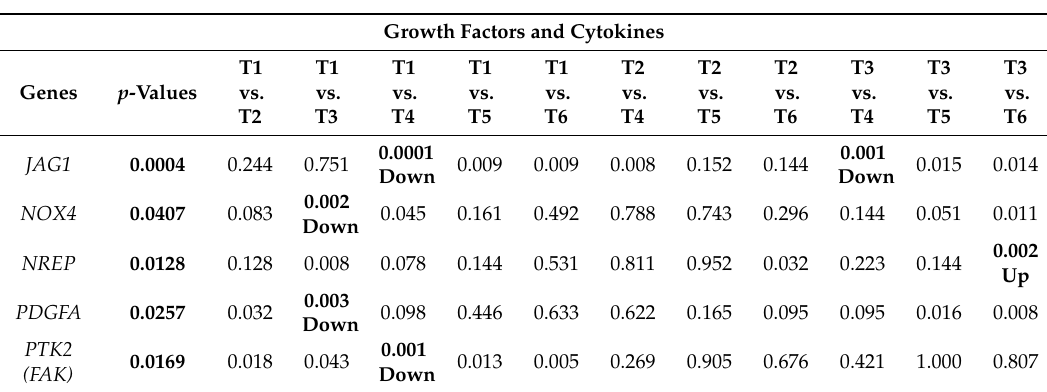
Table 7. Di ff erentially expressed genes coding for growth factors and cytokines.